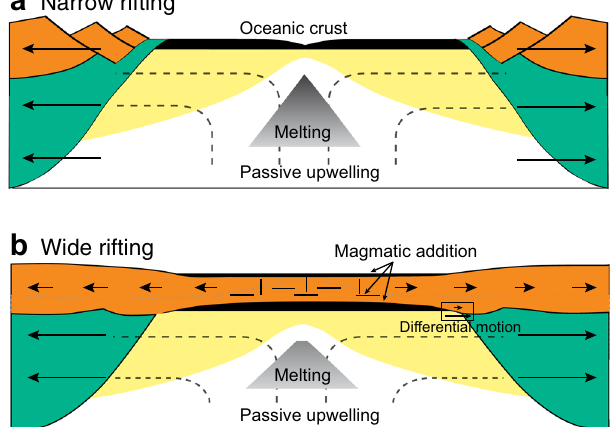
Fig. 7 Cartoon comparing magmatic outputs of narrow and wide rifting at normal mantle temperature. a Narrow rifting with simultaneous rupture of crust (orange) and mantle lithosphere (green), followed by accretion of normal oceanic crust (black). b Wide rifting with distributed deformation in the crust (orange) and narrow rupture of the mantle lithosphere. Note the differential motion between the crust and mantle lithosphere in wide rifting. Preferential removal of the mantle lithosphere leads to accumulation of magmatic addition (black) to the extending continental crust above. Note both narrow and wide rift scenarios have the same (normal) mantle potential temperature. Shown are melt window (grey region), new lithosphere (yellow), directions of extension (arrows) and fl ow path of passive mantle upwelling (dashed